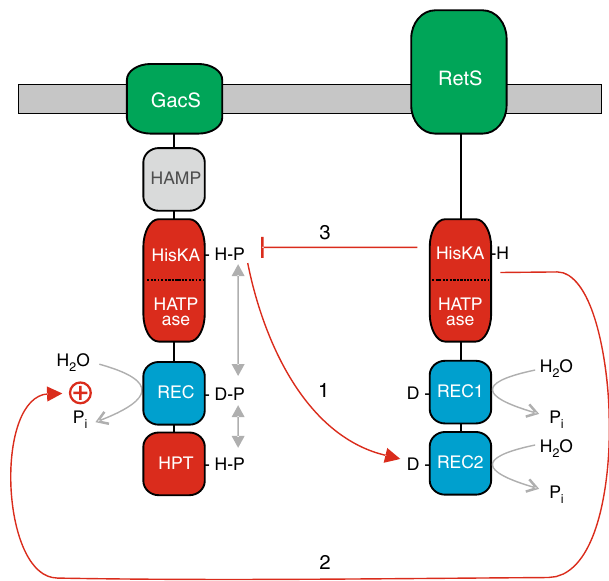
Fig. 6 The three mechanisms used by RetS to inhibit GacS signalling. Mechanism 1 — D858 in REC2 of RetS takes the phosphoryl group from the autophosphorylatable His residue in the HisKA domain of